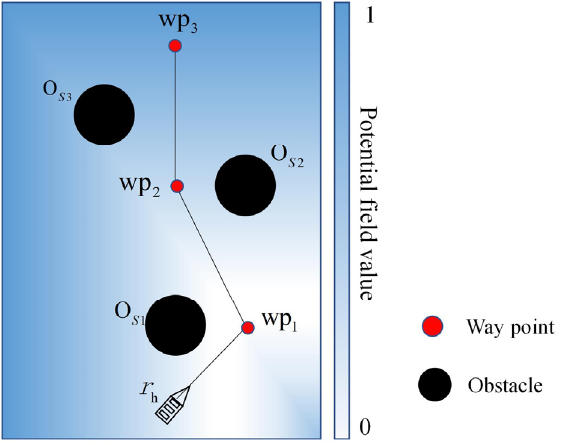
Figure 8. Process of leader ship passing through multiple waypoints.